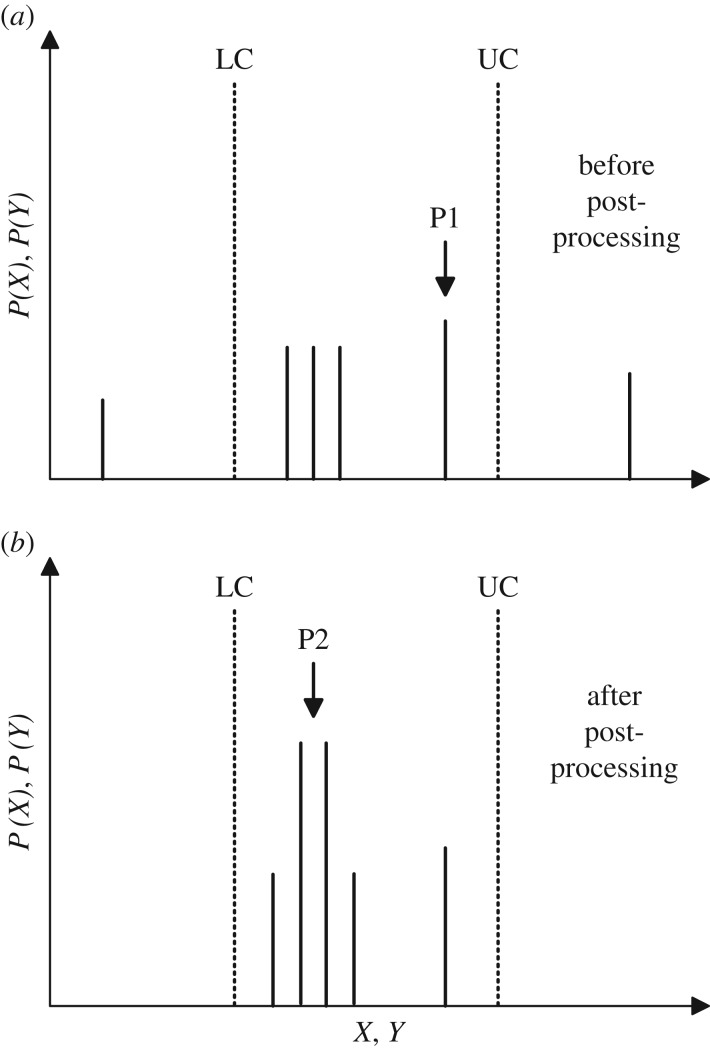
A schematic showing the post-processing of regression model predictions. Models output a probability distribution across the full range of X or Y . The dotted lines represent upper and lower constraints (UC/LC). Probabilities outside the constraints are set to zero. A square wave convolution is then applied which sums the probabilities of predictions over a small range in X or Y . This ensures that large clusters of small probabilities are used for predictions (P2) instead of individual outliers with only marginally larger probabilities (P1). The square wave window is of width 2 and increases in size until a peak is found with P>0.5. If the square wave reaches a width of 8 cells, the process is stopped and the output prediction is taken as the midpoint of the upper and lower constraints. Ignoring constraints, the convolution process improves regression predictions from an average error of 16.2 to 13.3 cells for Y and from 6.4 to 4.7 cells for X.